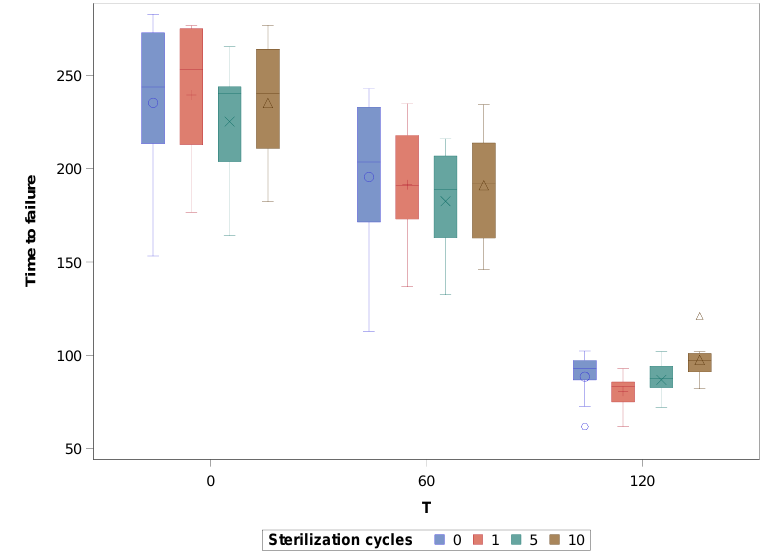
Figure 3. Box plot of the time to failure for the time of use and the sterilization cycles study groups. The horizontal line in each box represents the respective median value.